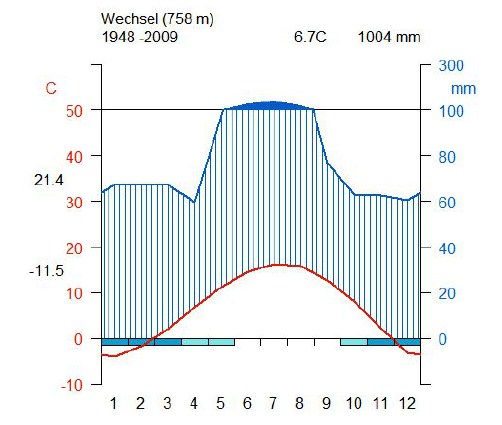
Figure 1. Walter–Lieth diagram, characterizing the climatic conditions at the experimental site, Wech- sel. The red line shows the monthly average air temperatures, the blue line shows the monthly sums of precipitation. The horizontal bar shows the duration of permanent (dark blue) and intermittent (light blue) snow cover. The mean maximum daily temperature (21.4 ◦ C) and the mean minimum daily temperature ( − 11.5 ◦ C) are also